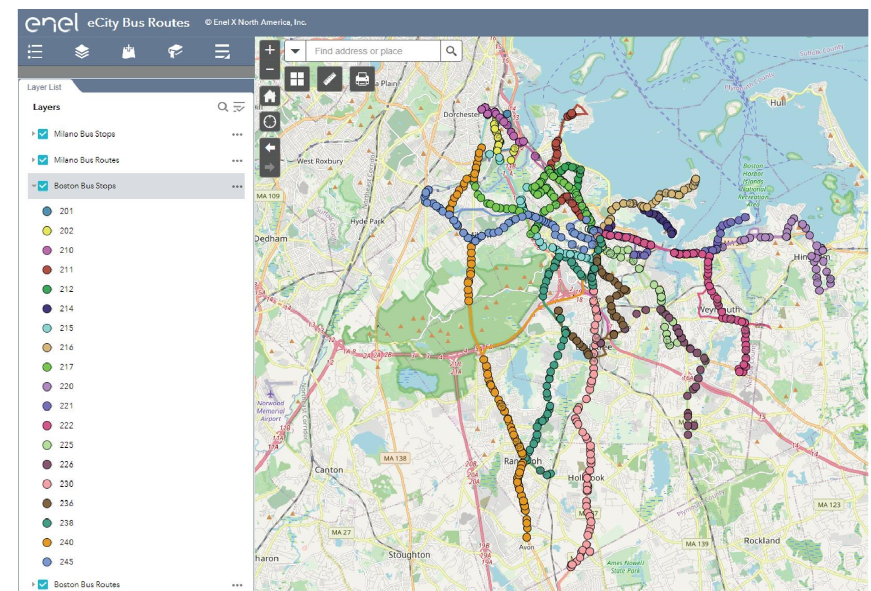
Figure 5: Route display for the Massachusetts Bay Transportation Authority (MBTA)